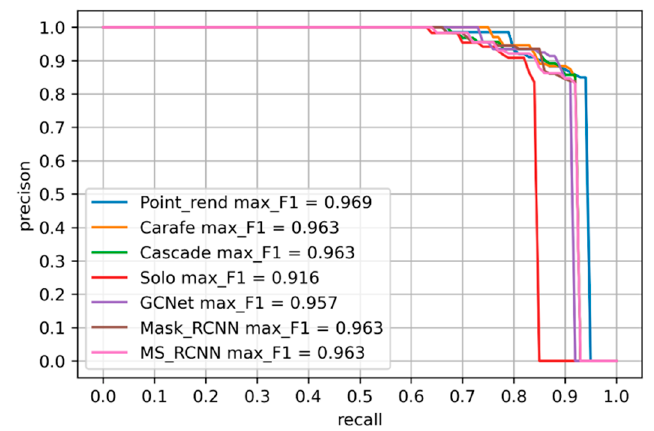
Figure 6. Precision-recall curve for each model on full Refuge dataset. F1 score is provided for each model.